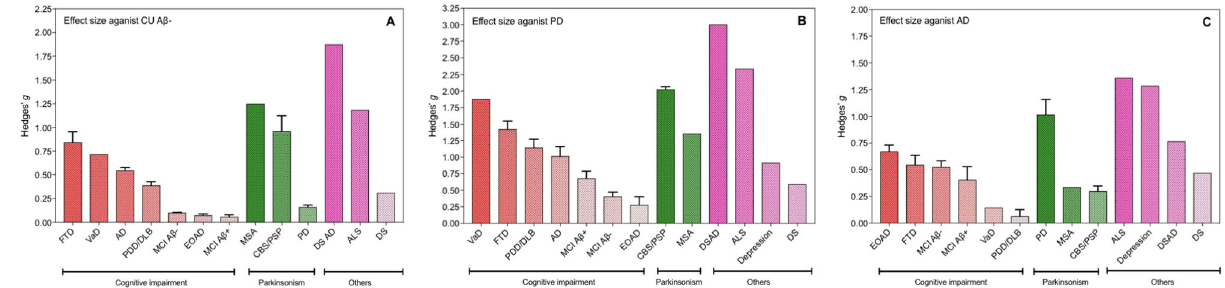
Fig. 2 Effect sizes of neurodegenerative disorders as compared to amyloid-negative cognitively unimpaired controls, Parkinson ’ s disease and Alzheimer ’ s disease. Effect sizes (Hedges ’ s g ) of different neurodegenerative disorders as compared to amyloid-negative cognitively unimpaired controls ( A n = 403), Parkinson ’ s disease ( B n = 311), and Alzheimer ’ s disease ( C n = 236). The bars represent the mean effect size for the cohort, whereas the error bars represent the standard deviation of effect size when considering the KCL and Lund cohorts separately. Those without error bars (e.g., VaD) are only included in one cohort. AD Alzheimer ’ s disease ( n = 236), ALS amyotrophic lateral sclerosis ( n = 50), CU A β − cognitively unimpaired without A β pathology ( n = 403), CBS/PSP corticobasal syndrome and progressive supranuclear palsy ( n = 43), depression ( n = 37), DS Down syndrome ( n = 29), DSAD Down syndrome Alzheimer ’ s disease ( n = 12), EOAD early-onset Alzheimer ’ s disease ( n = 82), FTD frontotemporal dementia ( n = 204), MCI A β − mild cognitive impairment without A β pathology ( n = 170), MCI A β + mild cognitive impairment with A β pathology ( n = 196), MSA multiple system atrophy ( n = 29), PD Parkinson ’ s disease ( n = 311), PDD/DLB Parkinson ’ s disease dementia and dementia with Lewy bodies ( n = 105), VaD vascular dementia ( n =